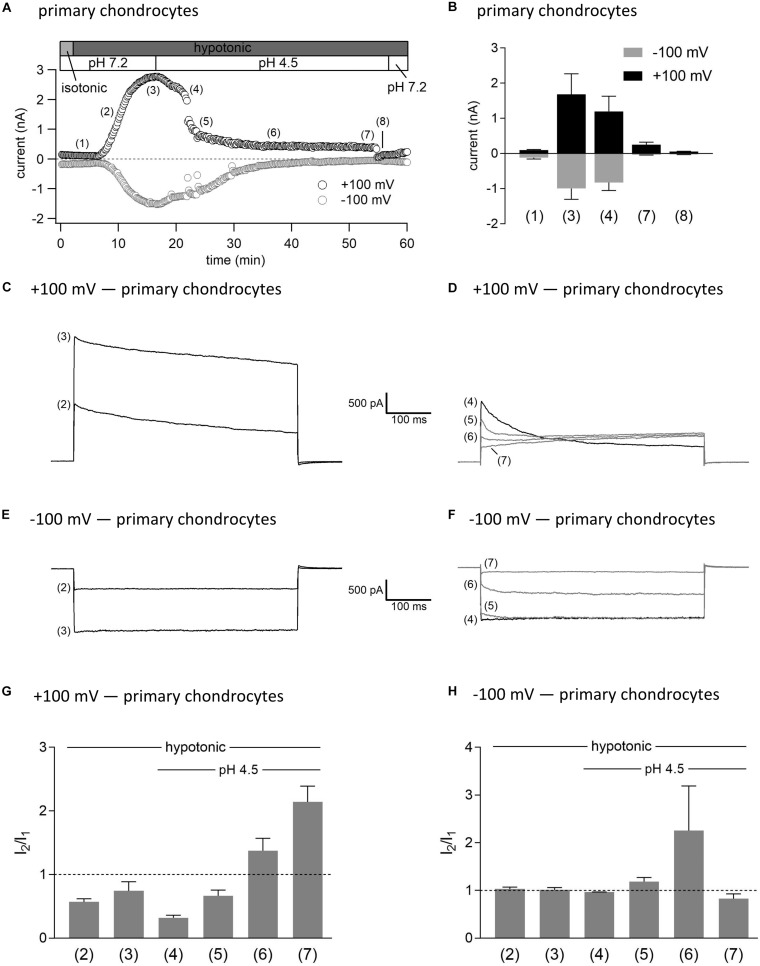
Interplay between ASOR and VSOR currents in primary human chondrocytes—effect of external acidification on VSOR currents. (A) Time course of a single experiment under isotonic (300 mosm/kg) and hypotonic (220 mosm/kg) conditions at pH 7.2 or 4.5 as indicated. Each circle represents the current at +100 mV (upper trace) and –100 mV (lower trace) measured in response to 500-ms voltage ramps applied every 10 s. (B) Mean current amplitudes ± SEM measured at the timepoints (1)–(8) as indicated in (A) (n = 3). Representative current traces in response to 500-ms voltage steps to +100 and –100 mV recorded at the timepoints marked in (A) at +100 mV (C,D) and –100 mV (E,F). I2/I1 ratios ± SEM obtained at the timepoints indicated in (A) at +100 mV (n = 2–3) (G) and at –100 mV (n = 2–3) (H); I2/I1 ratio > 1, time-dependent activation; I2/I1 ratio < 1, time-dependent inactivation.